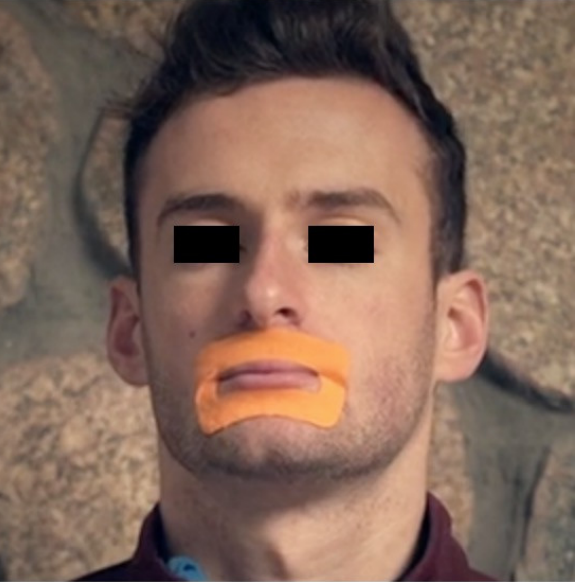
mentary material (Video